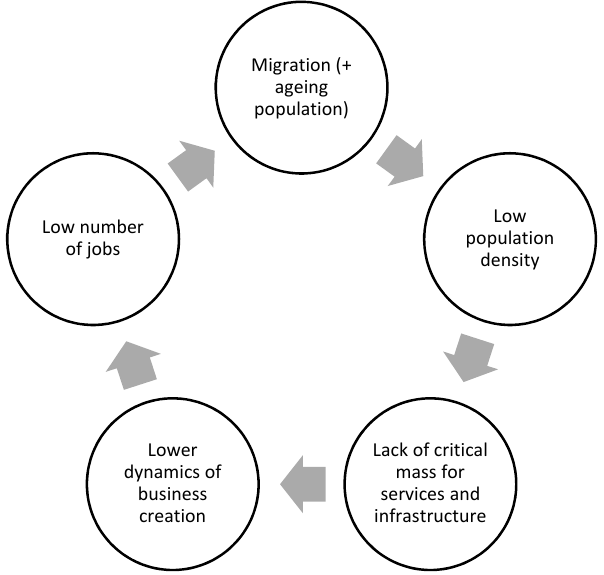
Figure 1. The vicious circle of decline in rural areas. Source : elaboration based on [10].